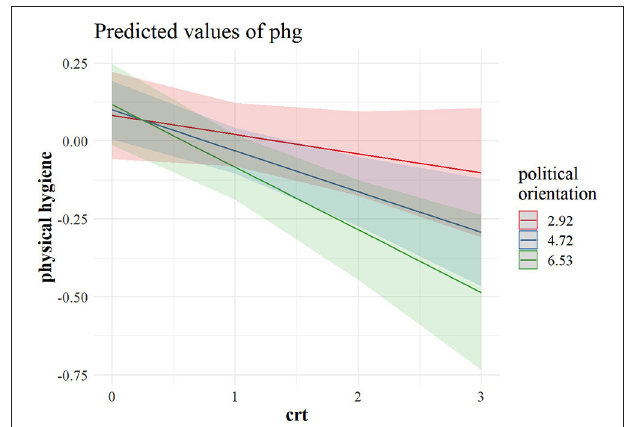
FIGURE 3 | Marginal predicted values for stricter physical hygiene maintenance from a model interacting CRT and political orientation in the Canadian sample ( n = 740). The predictor values for left (2.29), centrist (4.72), and right (6.53) political orientation are ± 1 SD . CRT values (0–3) indicate the number of correct responses. phg, stricter hygiene maintenance; crt, cognitive reflection.